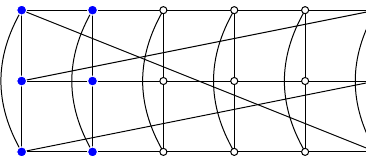
C 6 ∼ = C 18 (1, 6) with a zero forcing (cid:49)